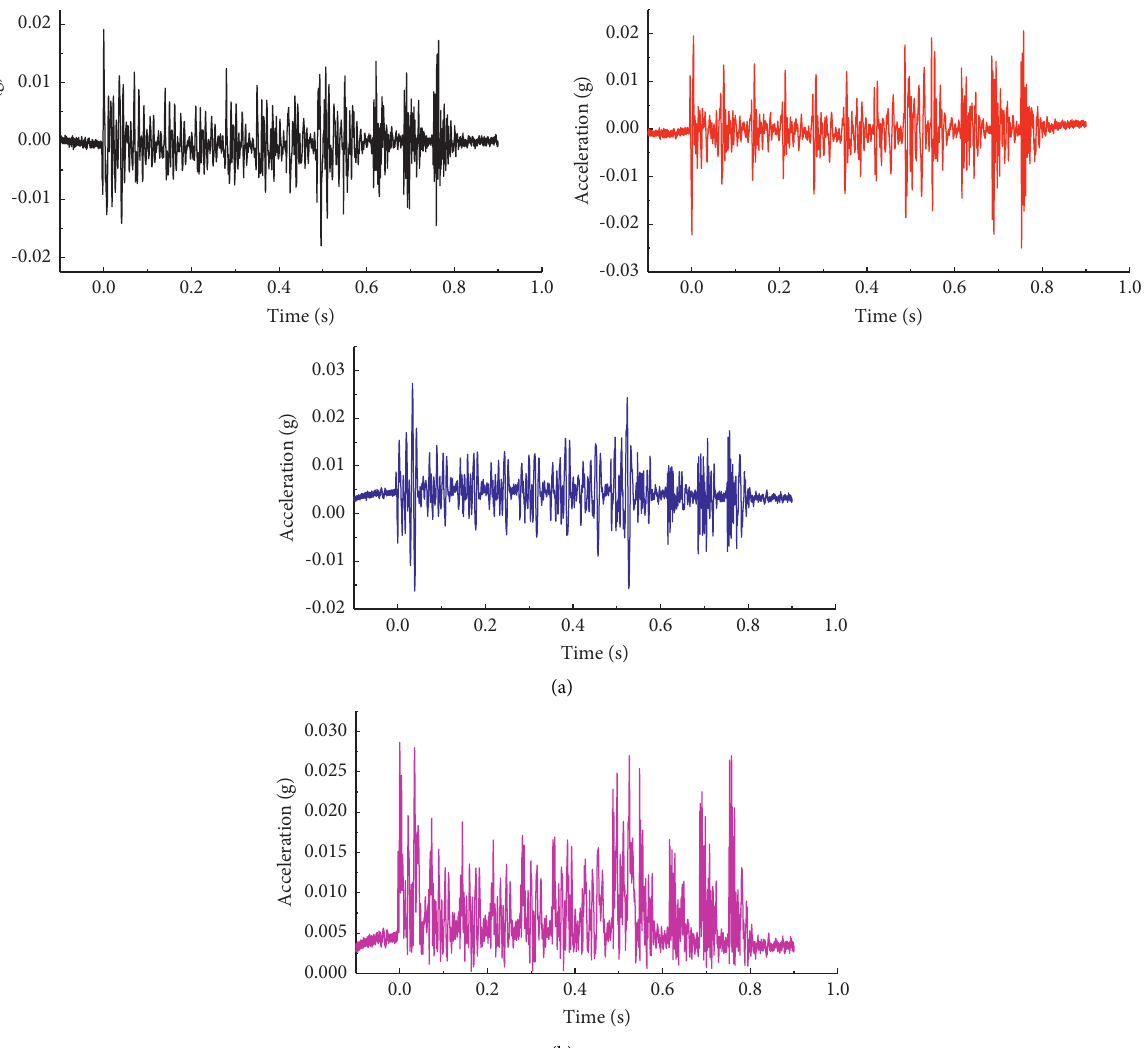
Figure 10: Acceleration waveform at 132.5m near tunnel blasting area. (a) Three-direction waveform of blasting vibration acceleration. (b) Total acceleration